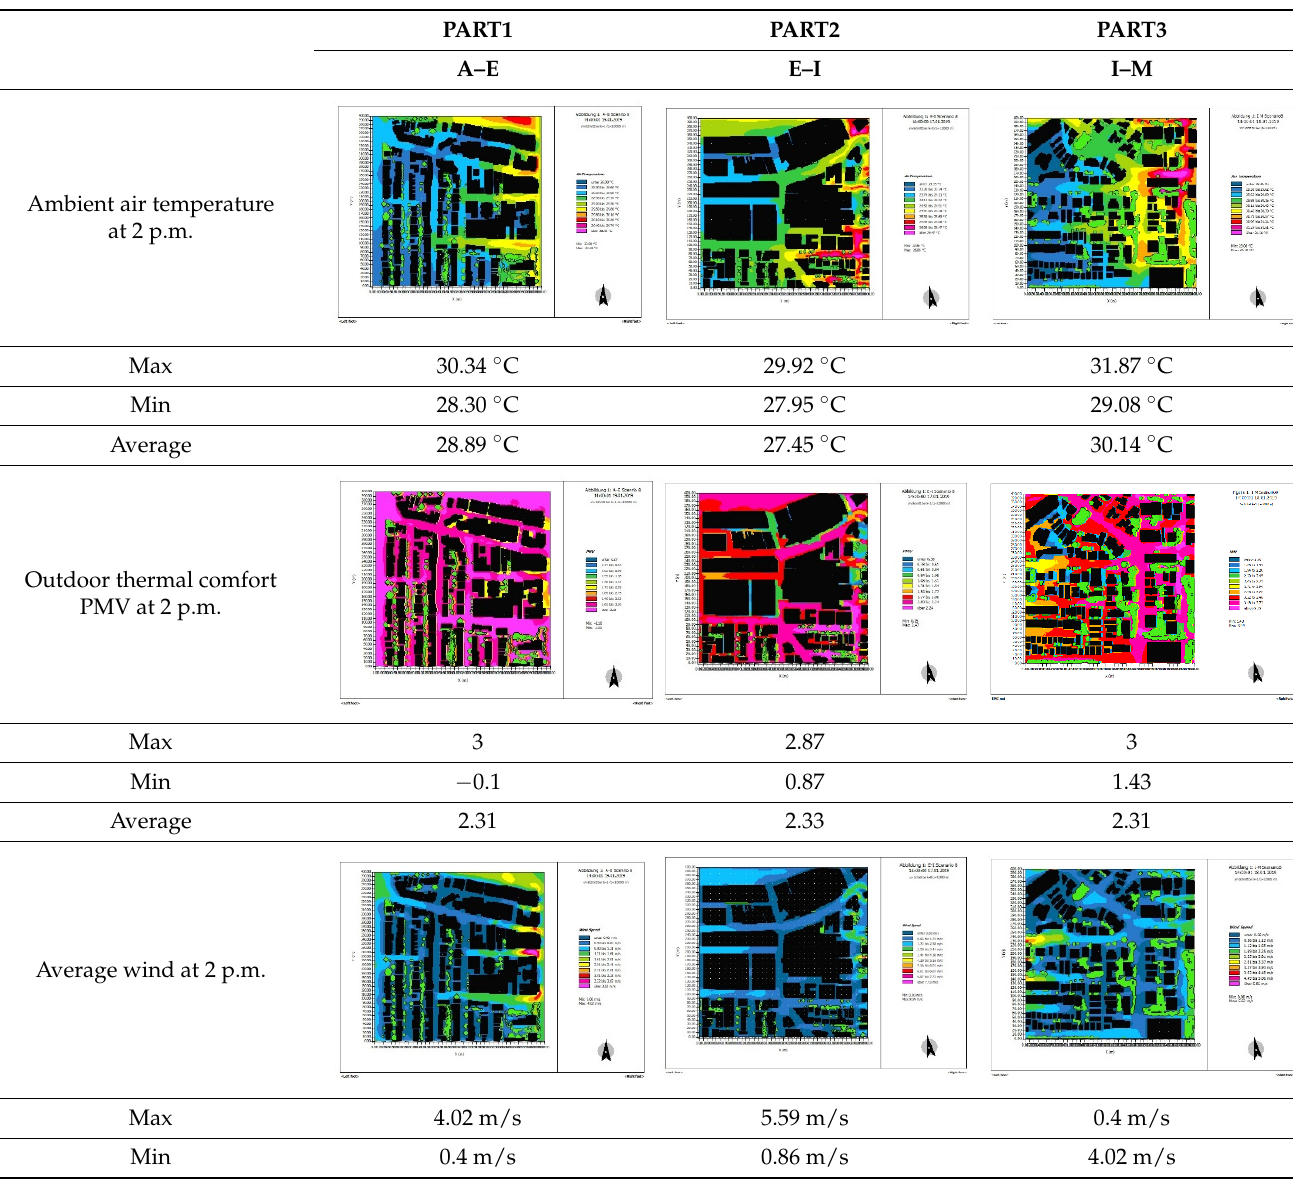
Table 15. Scenario eight ambient air temperature, outdoor thermal comfort, and wind speed dis- tribution maps in all parts at 2 pm.